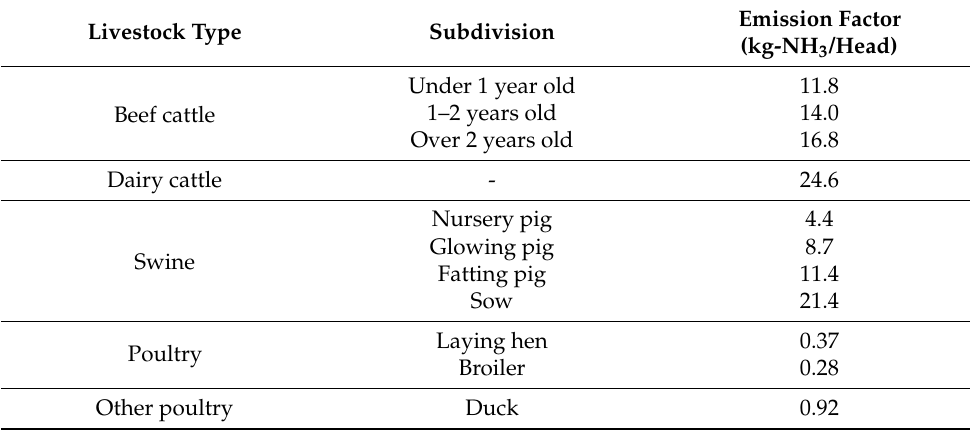
Table 2. Ammonia emission factor by livestock type.